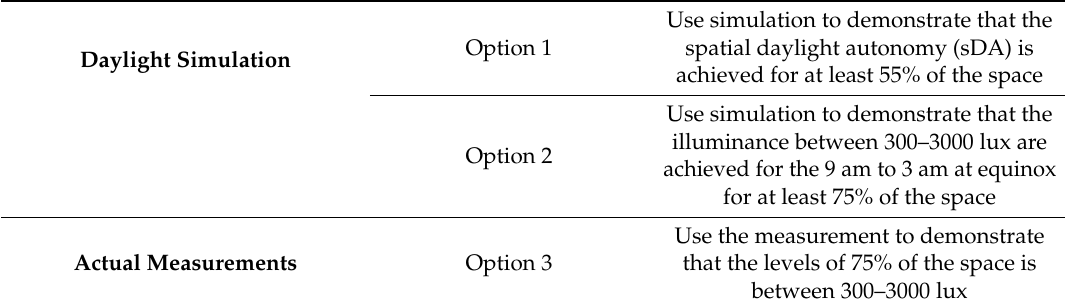
Table 4. Compliance Options for the Leadership in Energy and Environmental Design system (LEED) v4 in Relation to Indoor Environmental Quality (IEQ).